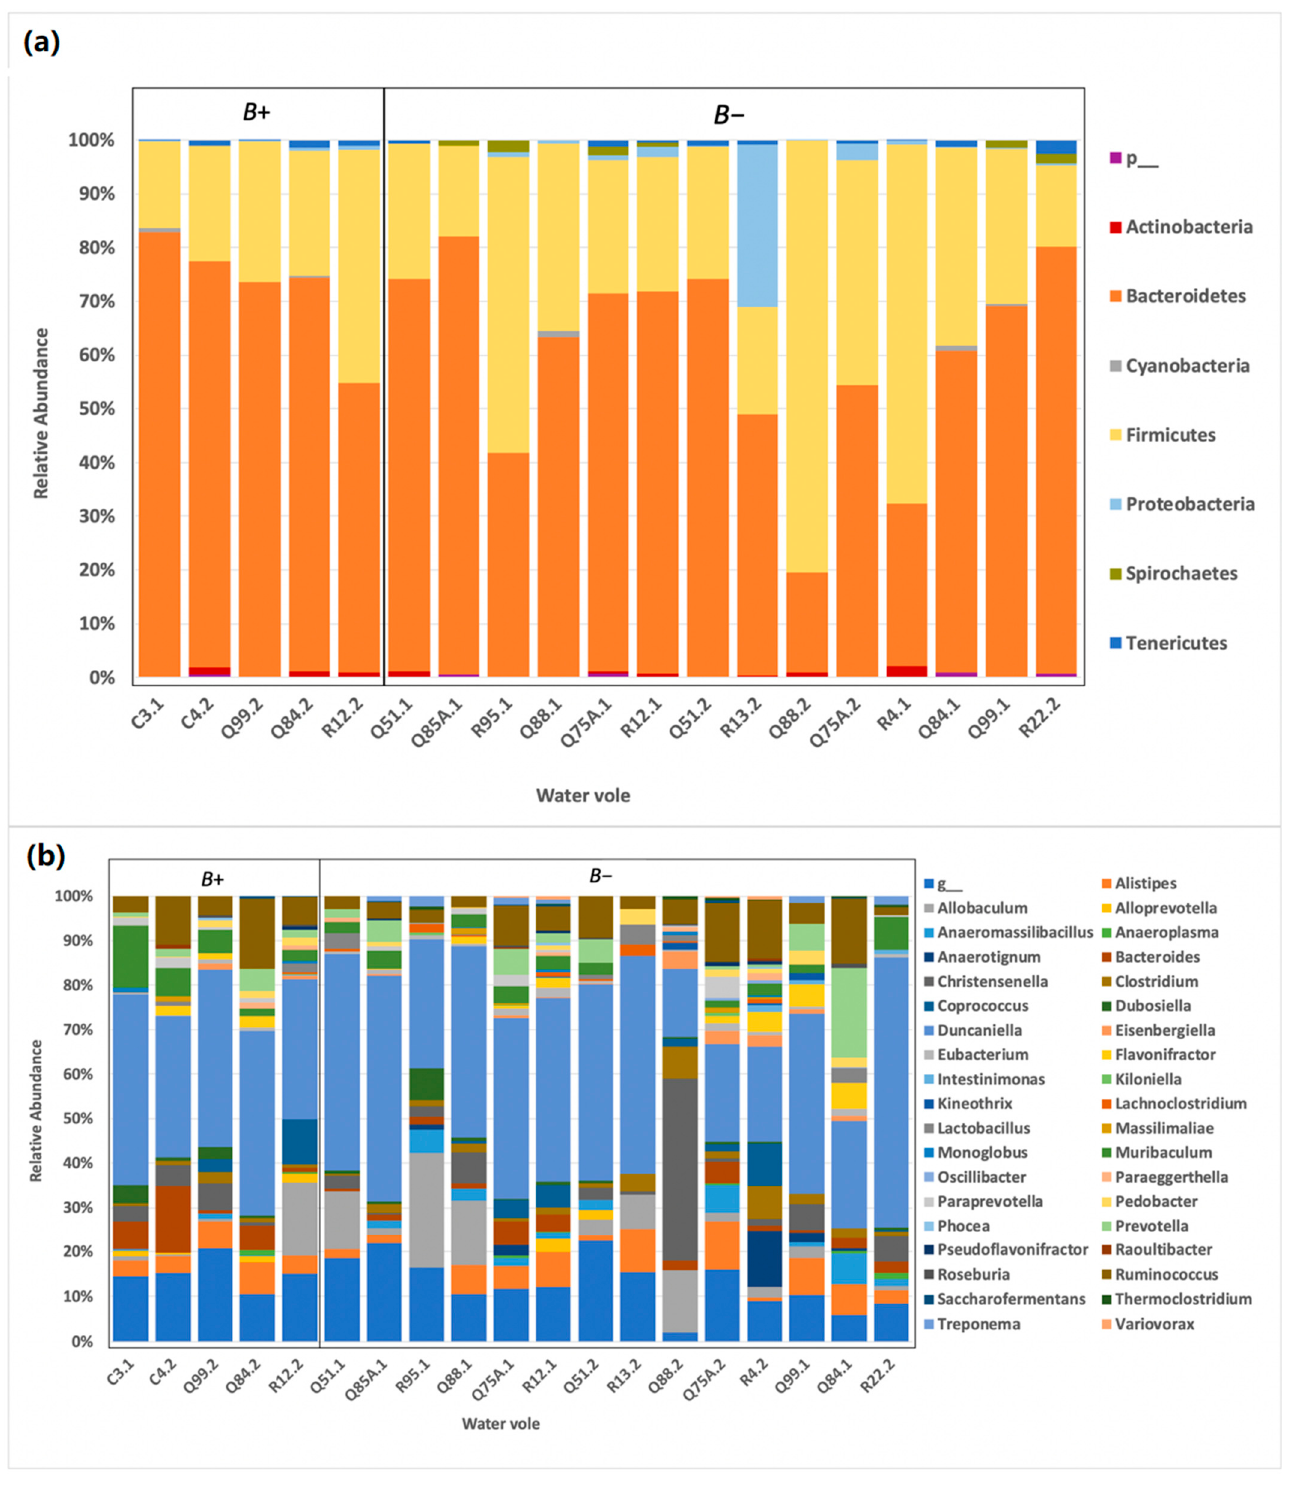
Figure 2. Relative abundance of OTUs separating Blastocystis and negative samples. ( a ) Relative taxa abundance of Blastocystis positive voles B+ and Blastocystis negative voles B − at the phylum level. Between the two groups, the relative abundance of OTUs at the phylum level are consistent. ( b ) Relative taxa abundance of Blastocystis positive voles B+ and Blastocystis negative voles B − at Table 1 across all samples, where g_ signifies all merged OTU genus data that have a relative abundance that is below 1% across all samples.